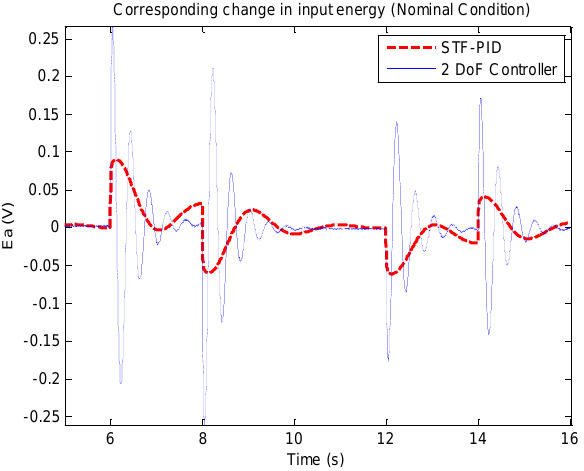
Figure 10. Corresponding change in input energy for the period from t = 5 s to t = 16 s.